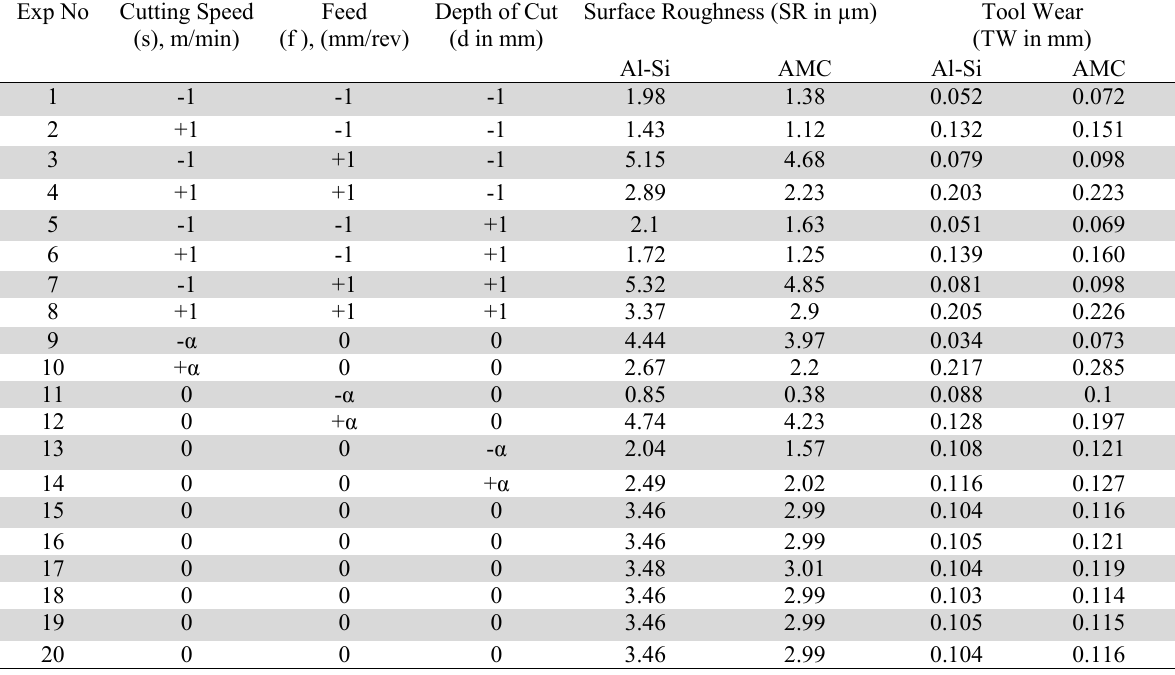
Experimental results obtained in machining Al-Si alloy and composite samples Exp No